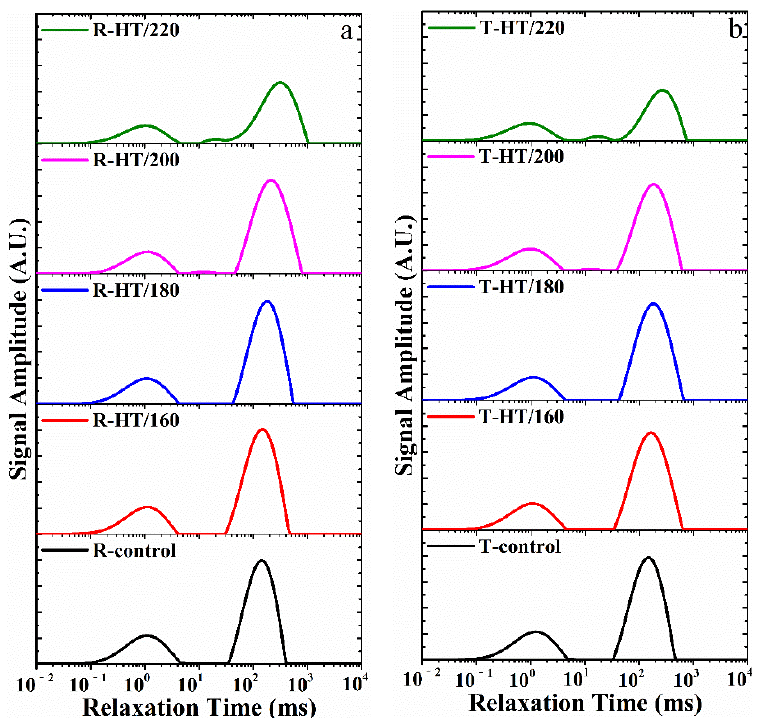
Figure 4. The T 2 curves of the heat-treated samples and the references after 60 days of water